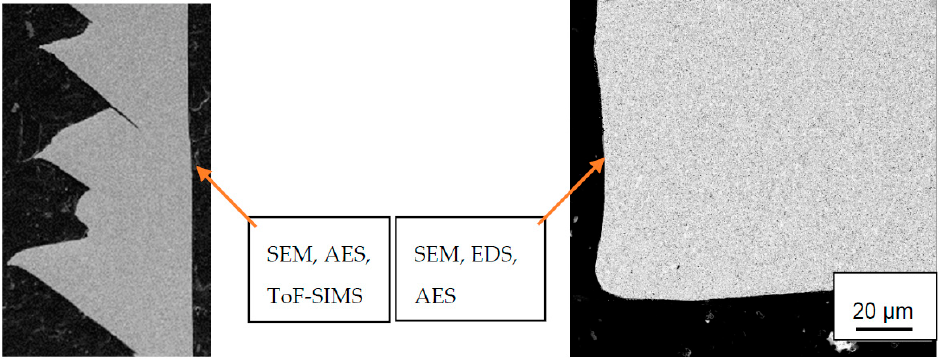
Figure 3. Cross-sections of Ti6Al4V chip and cemented carbide insert (to scale) and applied surface analysis techniques in this study.